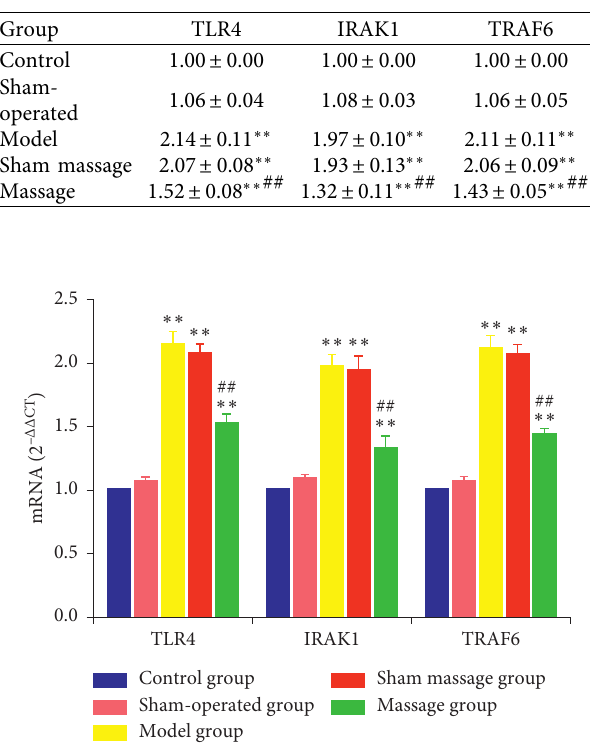
Figure 3: TLR4, IRAK1, and TRAF6 mRNA expression 14 days after surgery. ∗∗ P < 0 . 01 compared with the control group; ## P < 0 . 01 compared with the model group. Table 5: The expression of TNF- α and IL-6 in each group on the 14th day after surgery. ∗∗ P < 0 . 0 compared with the control group; ## P < 0 . 01 compared with the model group.